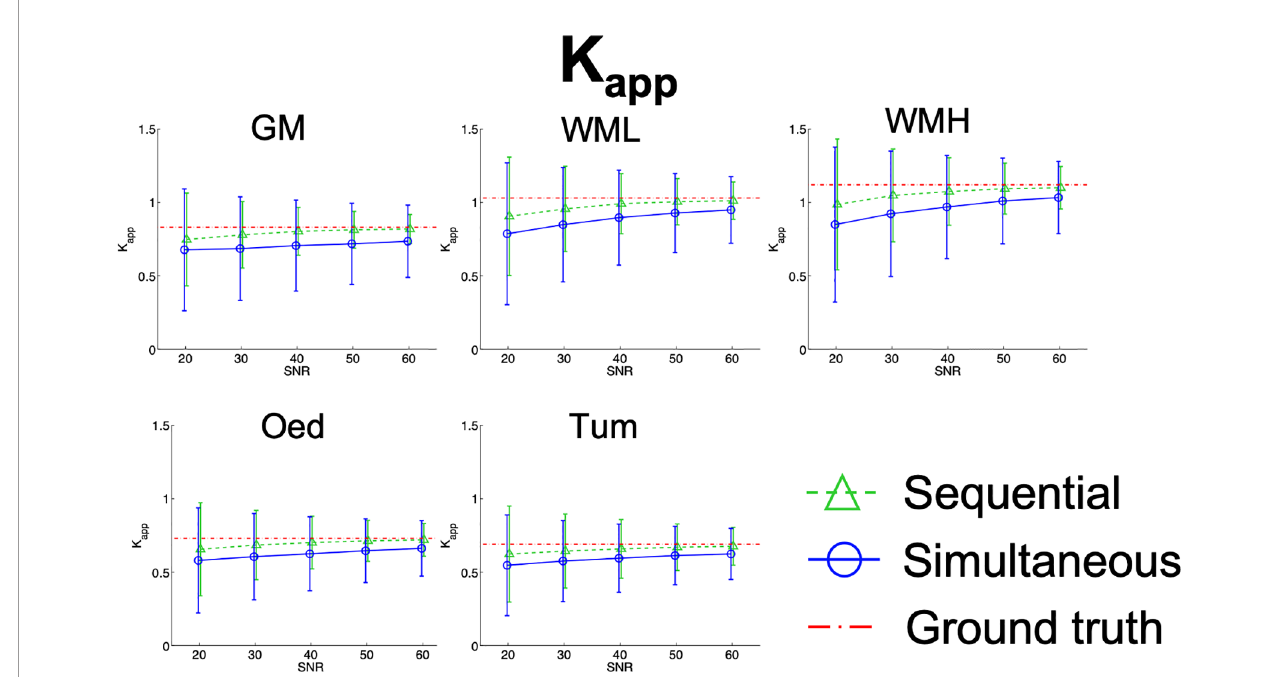
FIGURE 10 | Simulation results plots of K app in all tissues at all SNR levels. The geometric fi gures represent the mean and the vertical bars represent the standard deviation at each SNR